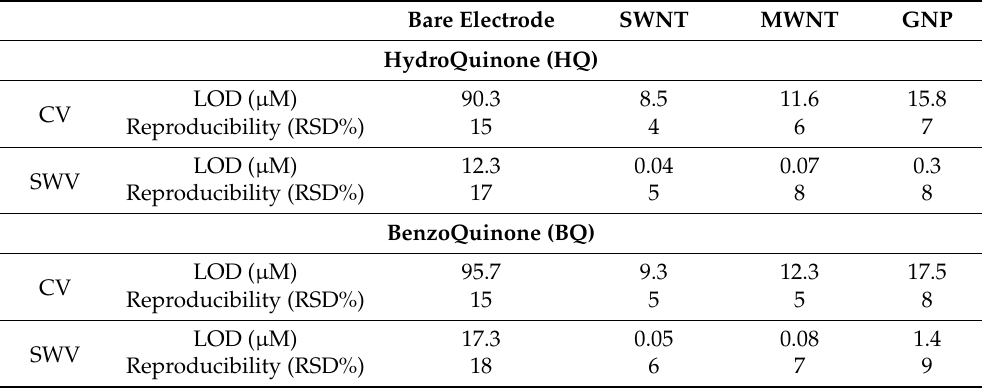
Table 2. Summary of the Limit of Detection (LOD) and reproducibility obtained using CV and SWV in the analyses of several concentrations of HQ and BQ in PBS solution. All analytical parameters are obtained from CV and SWV traces. Bare Electrode